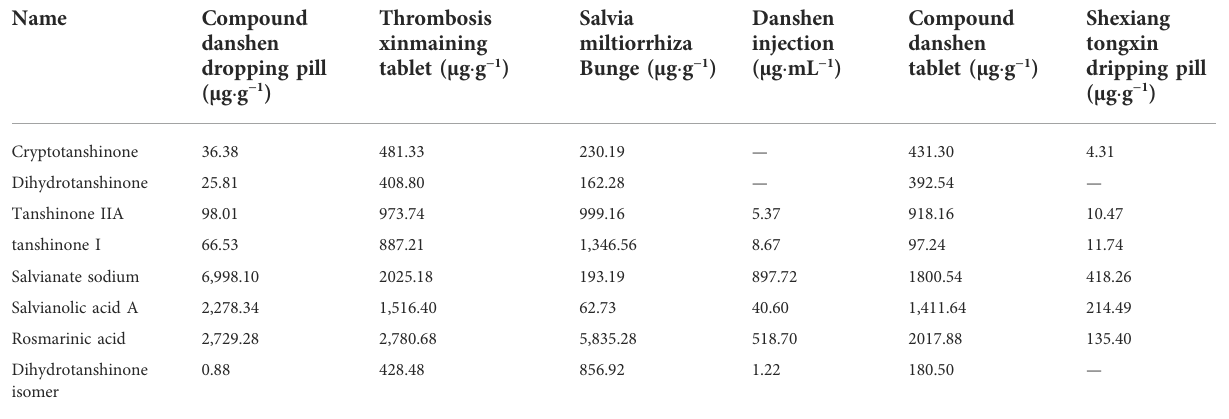
TABLE 3 The contents of the seven bioactive compounds in SMB and SMB derived